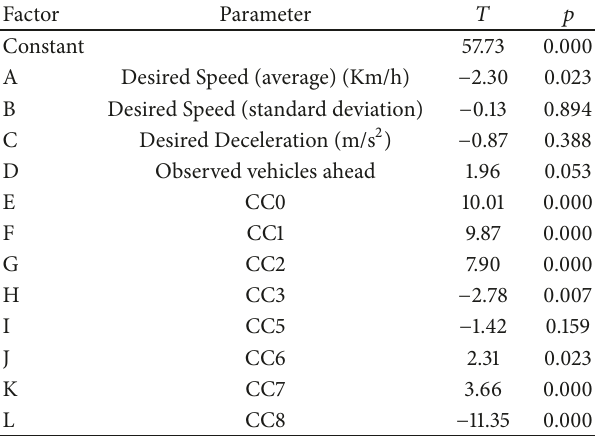
Table 6: Significance of factors according to ANOVA